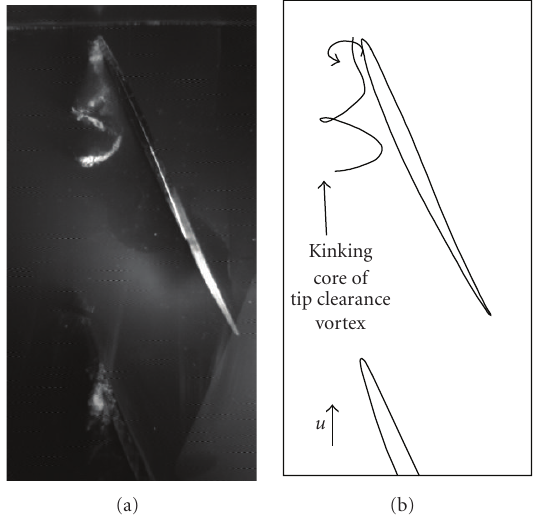
Figure 2: Vortex breakdown of the tip clearance vortex observed by Goltz